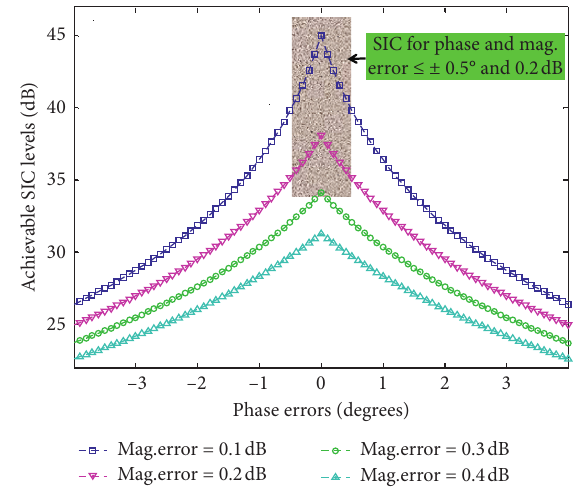
Figure 3: The effects of the amplitude and out-of-phase errors or imbalances of DFN on the achievable SIC levels.